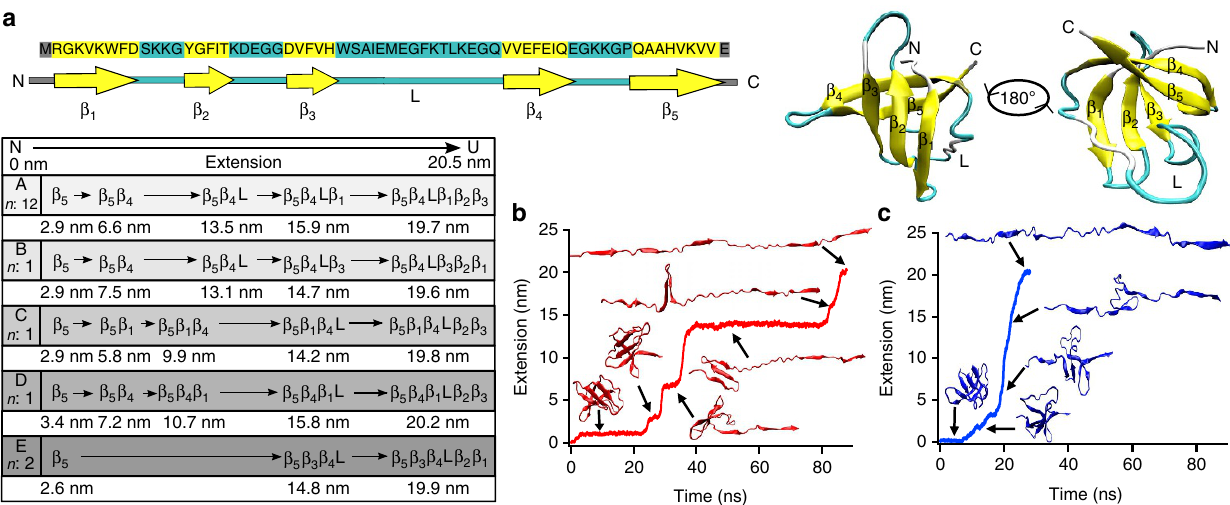
Figure 5 | Atomistic simulations of Csp mechanical unfolding. ( a ) Sequence, topology and three-dimensional structure (PDB: 1G6P) of Csp. Residues forming the b -strands are highlighted in yellow and residues forming loops are highlighted in cyan. The overview shows the results from the pathway analysis for the 17 unfolding trajectories. (with n number of trajectory) ( b ) Example of a simulated trajectory representing pathway A, where Csp starts unfolding from strand 5, followed by strand 4, the loop, strand 1 and then strands 2 and 3 together. ( c ) Example of a trajectory representing pathway C, where Csp starts unfolding from strand 5, followed by strand 1 and 4, the loop and then strands 2 and 3